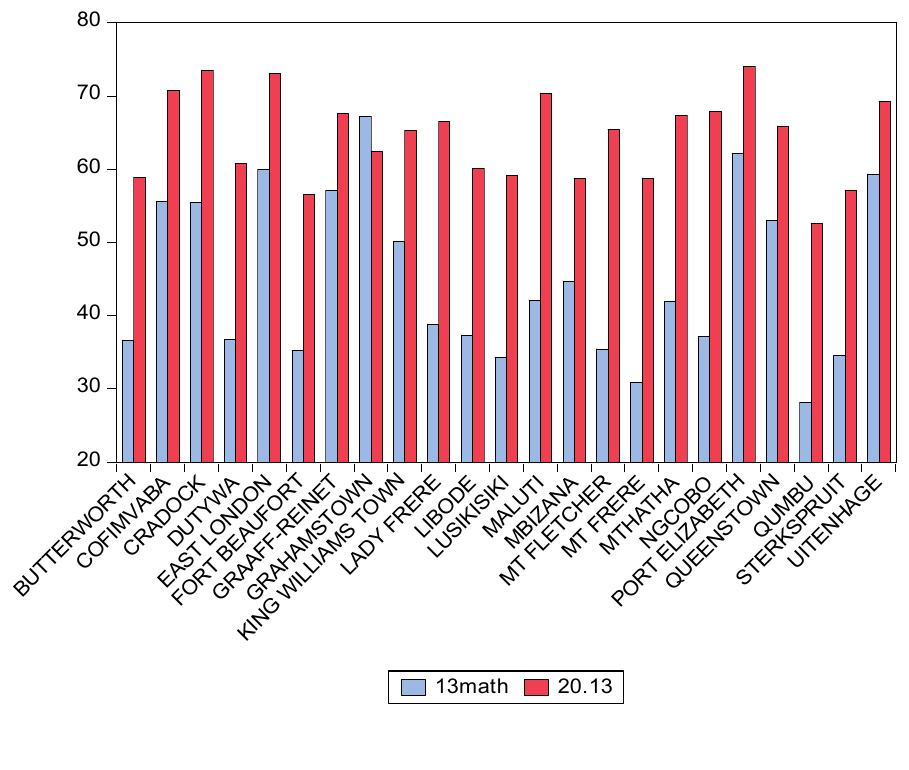
Figure 5: Grade 12 and Mathematics pass rate at district level,